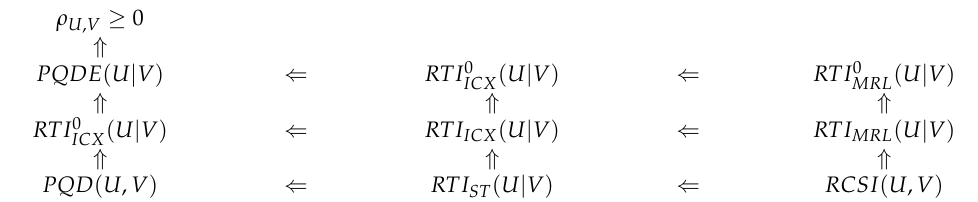
Table 6. Relationships among weak positive dependence